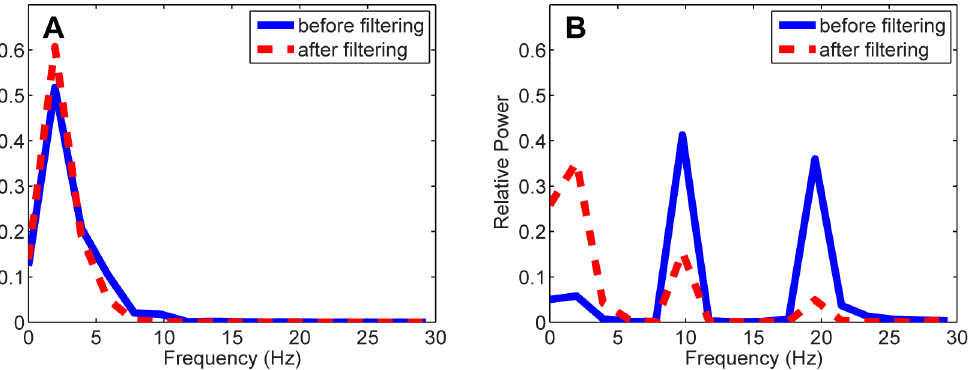
Figure 4. The relative power of ERP signals before and after being filtered by FIR filter 1 in Figure 3B. (A) shows the result of target ERP; (B) shows the result of distractor ERP.